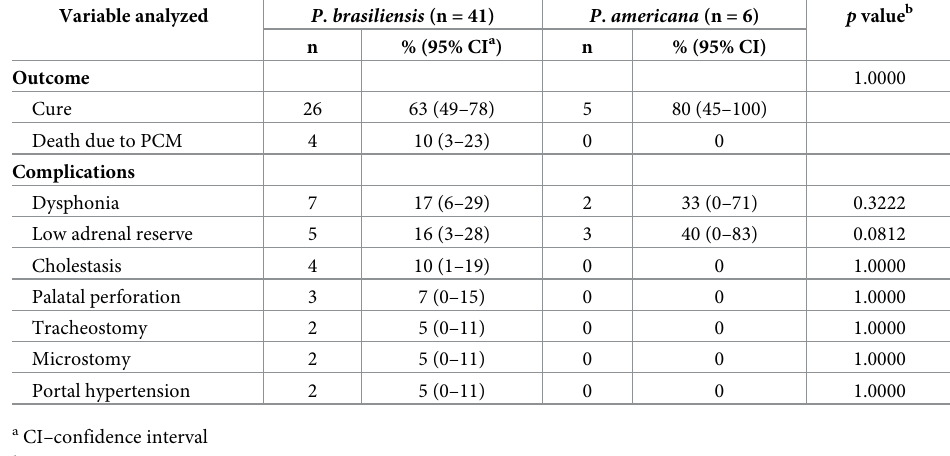
Table 4. Prognostic aspects of patients with paracoccidioidomycosis according to the species identified in this study. Variable